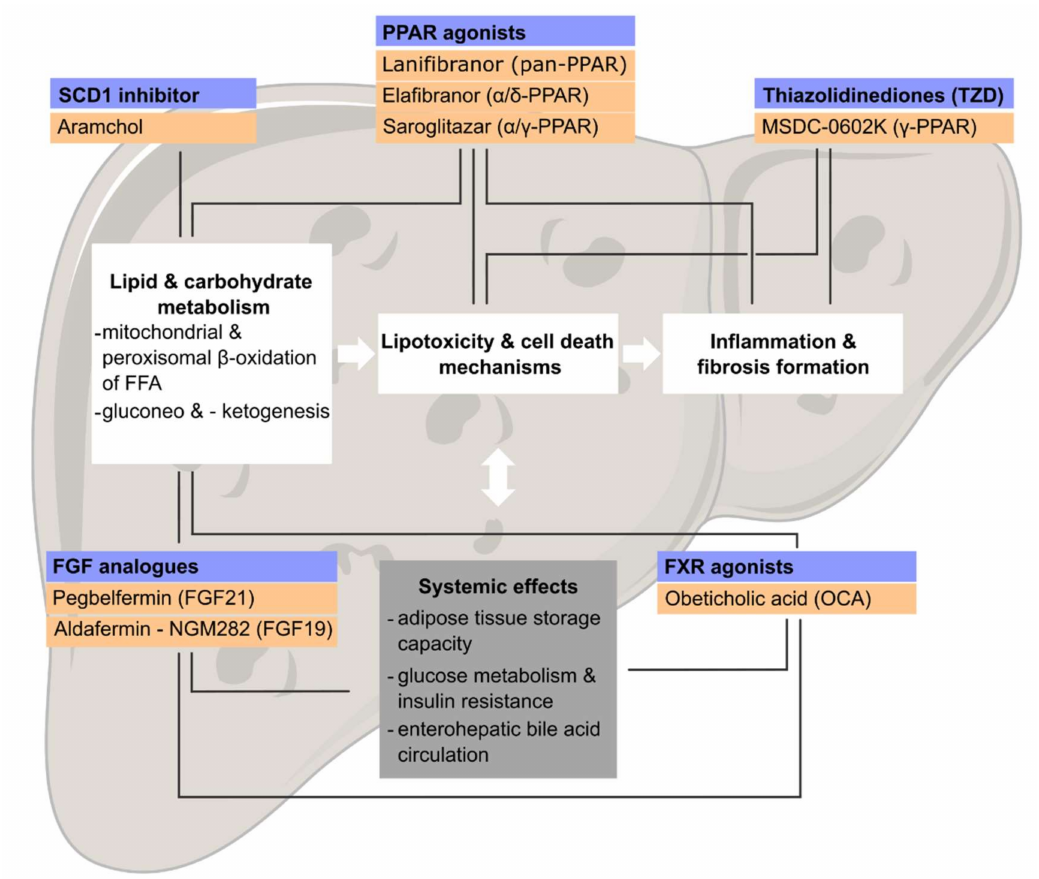
Figure 3. Novel pharmacologic compounds targeting metabolic and inflammatory pathways in NAFLD. During development and progression of NAFLD, multiple signalling pathways are dys- regulated. Preclinical and clinical studies identified many potential drug targets for the treatment of nonalcoholic steatohepatitis and fibrosis. Targeting metabolic and inflammatory mechanisms of action (blue) represent promising strategies, which led to the development of various therapeutic compounds (orange), which are currently under clinical investigation. SCD1, stearoyl-CoA desaturase 1; PPAR, peroxisome proliferator-activated receptor; FGF, fibroblast growth factor; FXR, Farnesoid X receptor; FFA, free fatty